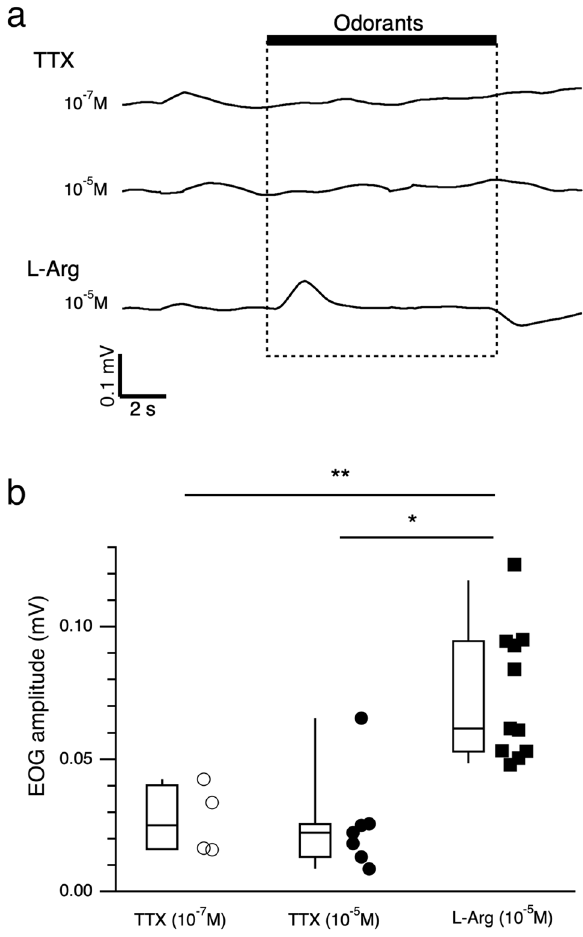
Figure 2. Grass puffer did not respond to TTX. ( a ) EOG responses of the olfactory epithelium of T. alboplumbeus to TTX (10 –7 M, upper trace; 10 –5 M, middle trace) and l-Arg (10 –5 M, under trace). ( b ) EOG amplitudes of TTX (10 –7 M, n = 6, open circle; 10 –5 M, n = 7, filled circle) and l-Arg (10 –5 M, n = 11, filled square). Box plots show the median, quartiles (boxes), and 10%–90% range (whiskers), and dot plots show raw EOG amplitudes. Steel’s multiple comparison test compared with l-Arg (TTX 10 −7 M, P = 0.009; TTX 10 −5 M, P = 0.011: *p < 0.05, **p <